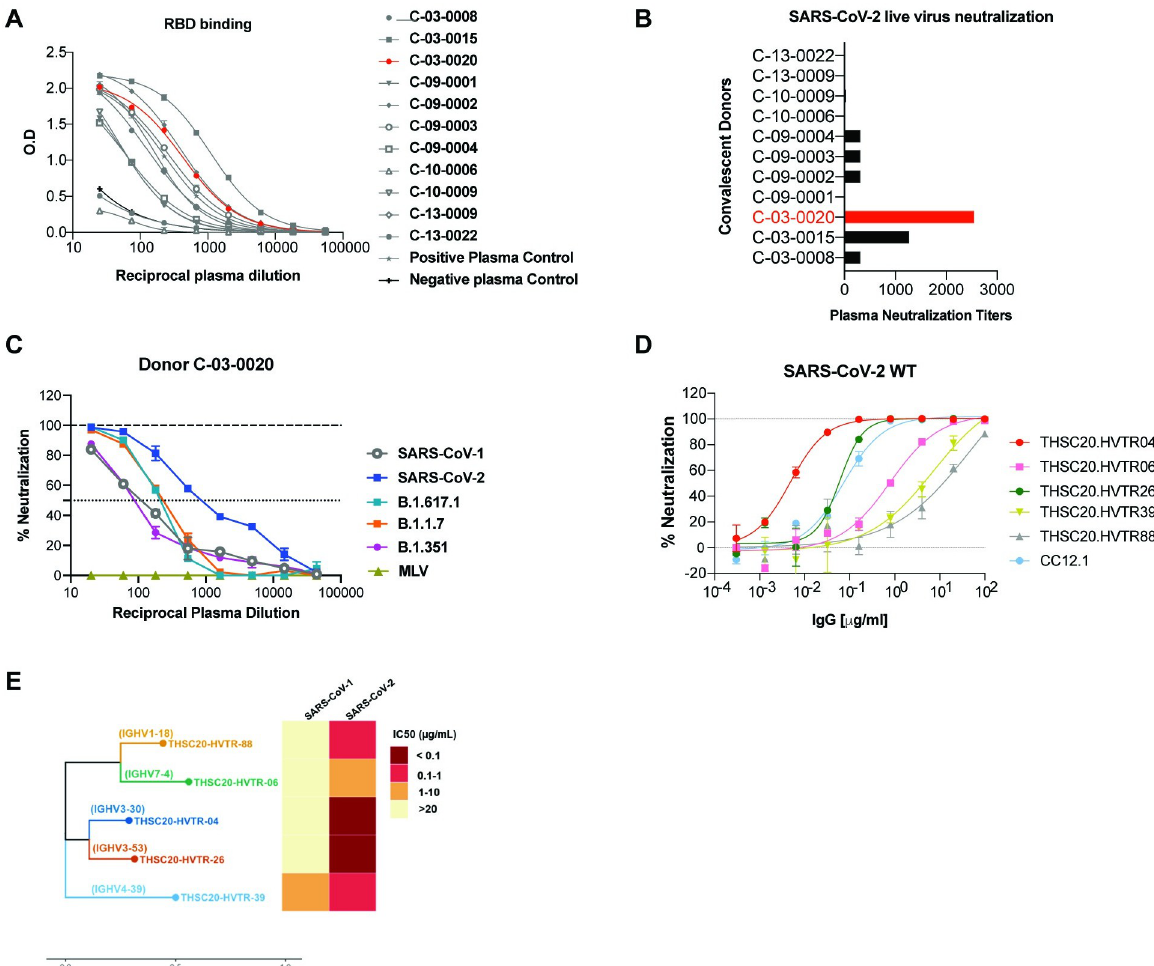
Fig 1. Isolation of neutralizing antibodies from the memory B cells of a convalescent donor. A . Identification of C-03-0020 donor with significant binding to SARS-CoV-2 RBD. B . High neutralizing activity of C-03-0020 plasma against SARS-CoV-2 in live virus neutralization assay. C . High neutralizing activity of C-03-0020 plasma against SARS-CoV-2 in pseudovirus neutralization assay. D. Neutralization potential of RBD- reactive mAbs were evaluated against SARS-CoV-2 pseudovirus. E . CDRH3 sequence, germline usage neutralization potency of isolated mAbs against SARS-CoV and